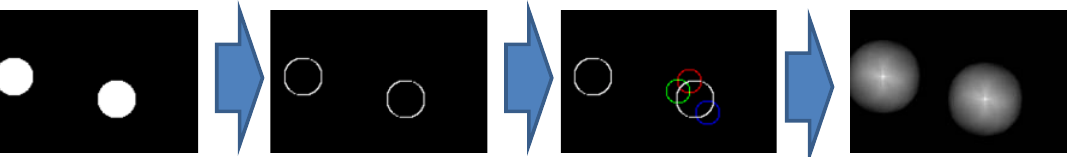
Figure 8. Scheme of the Hough